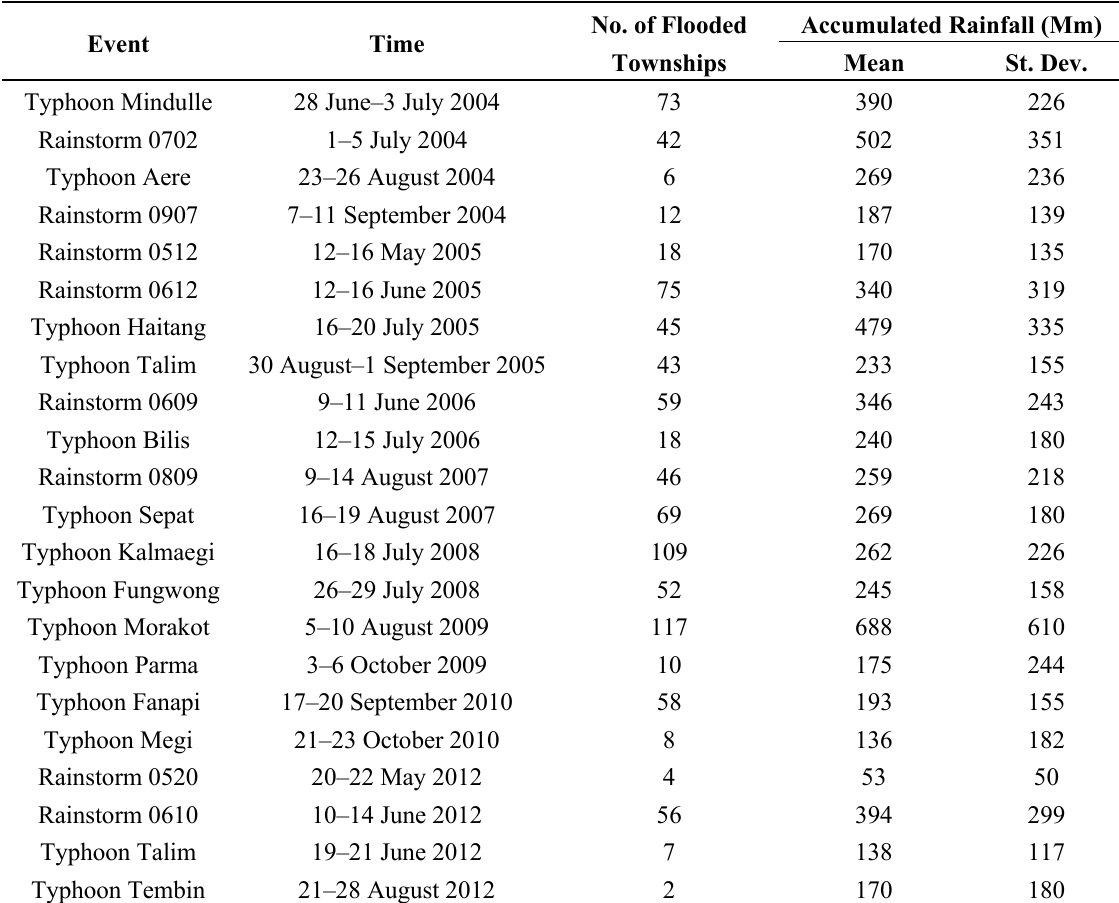
Table 1. Historical flood events for case